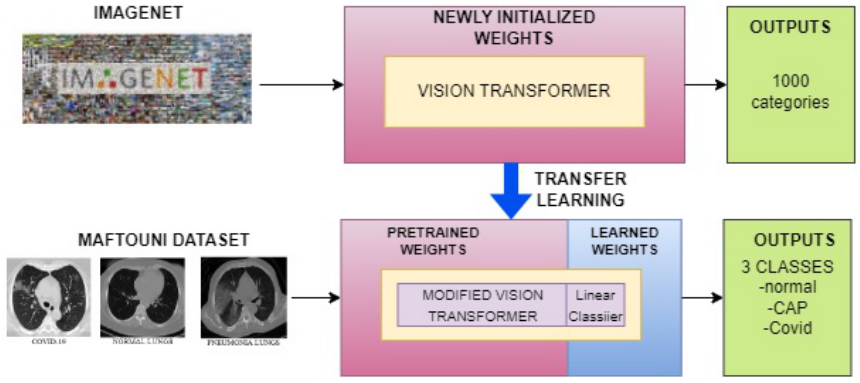
Figure 3. One-step Transfer Learning